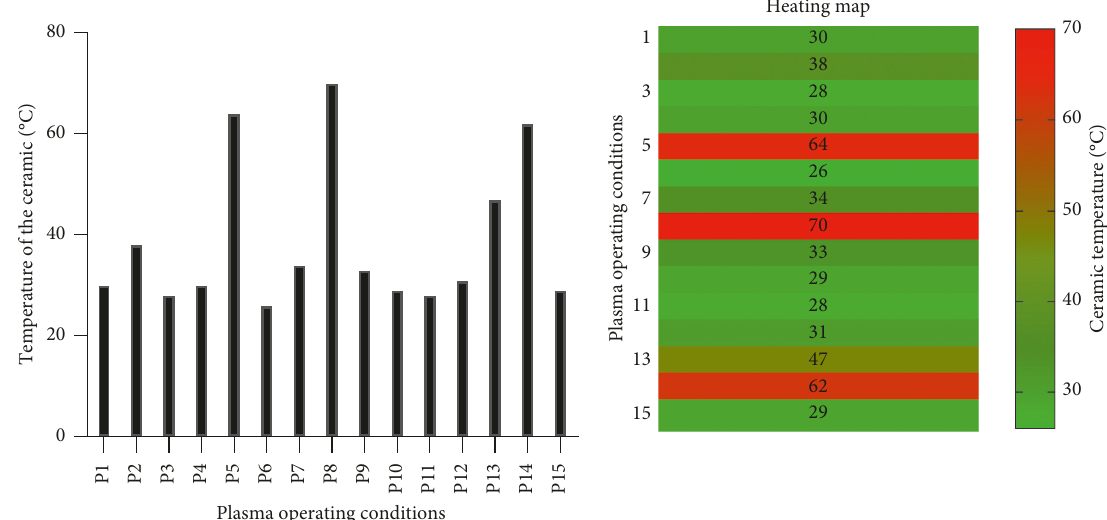
Figure 3: Temperature of ceramic at different plasma operating